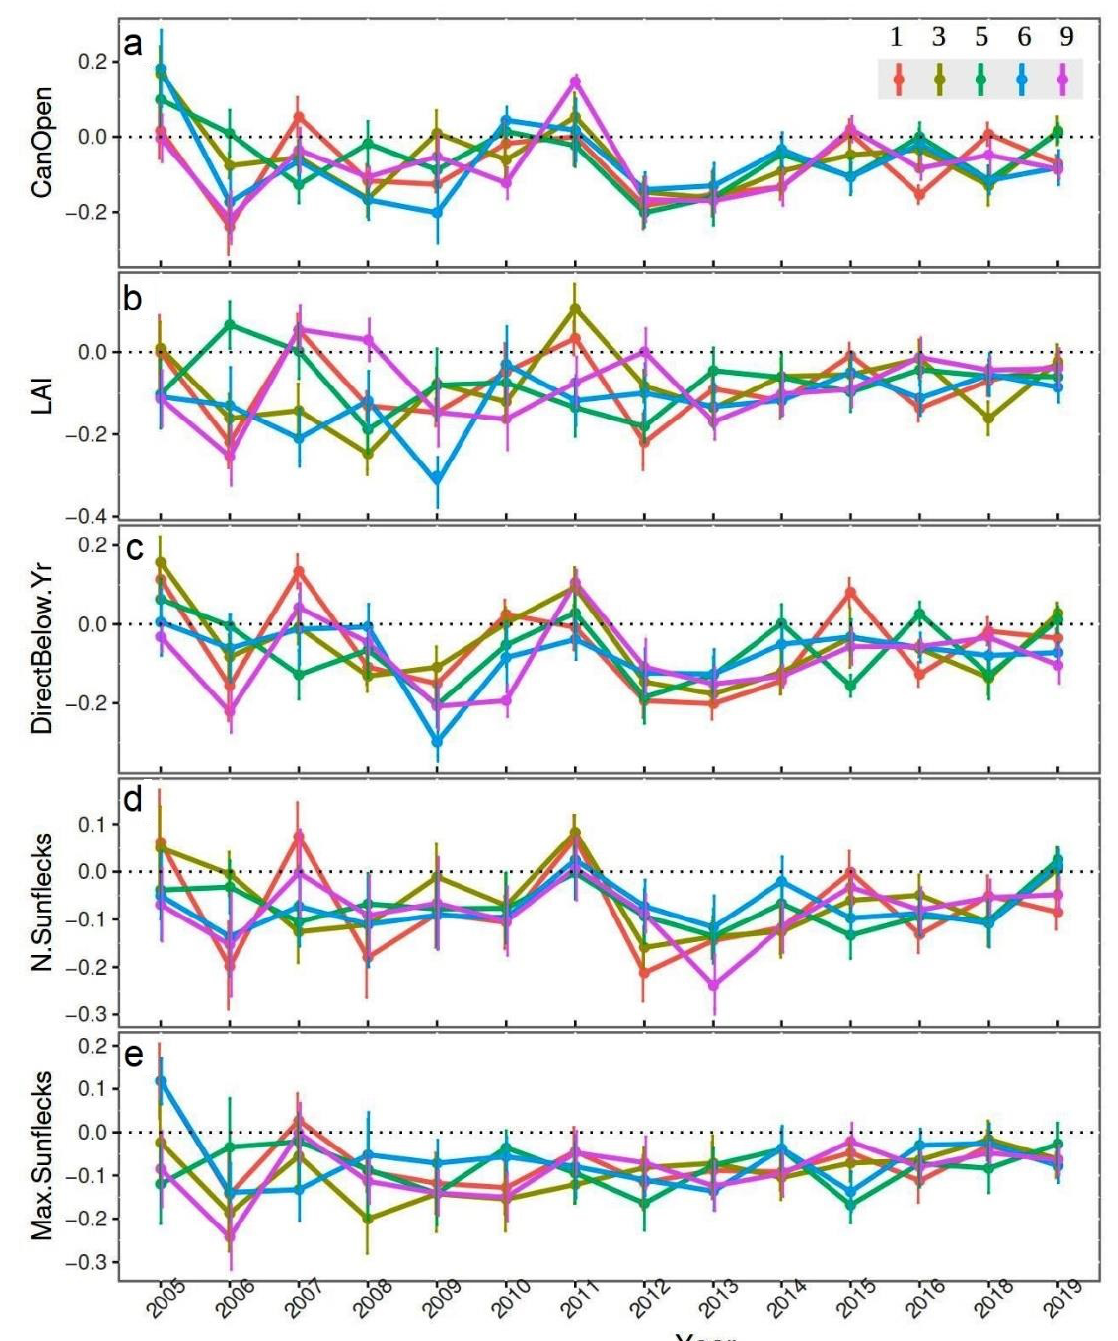
Figure 2. Light variables from the hemispherical photograaphs during the studied years for the five plots that showed Figure 3. Partial autocorrelation functions (PACFs) for light variables over the studied years for the five plots with the larger changes over time: ( a ) CanOpen (parts per unit), ( b ) LAI (m 2 m − 2 ), ( c ) DirectBelow.Yr ( µ mol m − 2 s − 1) , ( d ) N.Sunflecks clearest trends. ( a ) CanOpen , ( b ) LAI, ( c ) DirectBelow.Yr , ( d ) N.Sunflecks , and ( e ) Max.Sunflecks . Each line represents different ( µ mol m − 2 s − 1 ), and ( e ) Max.Sunflecks (minutes). Each line corresponds to different plots. For each light variable, horizontal plots. The y-axis represents the values the PACF can take (from 1.0 to –1.0), and the x-axis represents the years. For y-axis, lines represent the mean values whereas vertical lines symbolize standard values close to zero (dashed lines) show that there was no temporal autocorrelation of the values of each light variable with respect to the previous year.